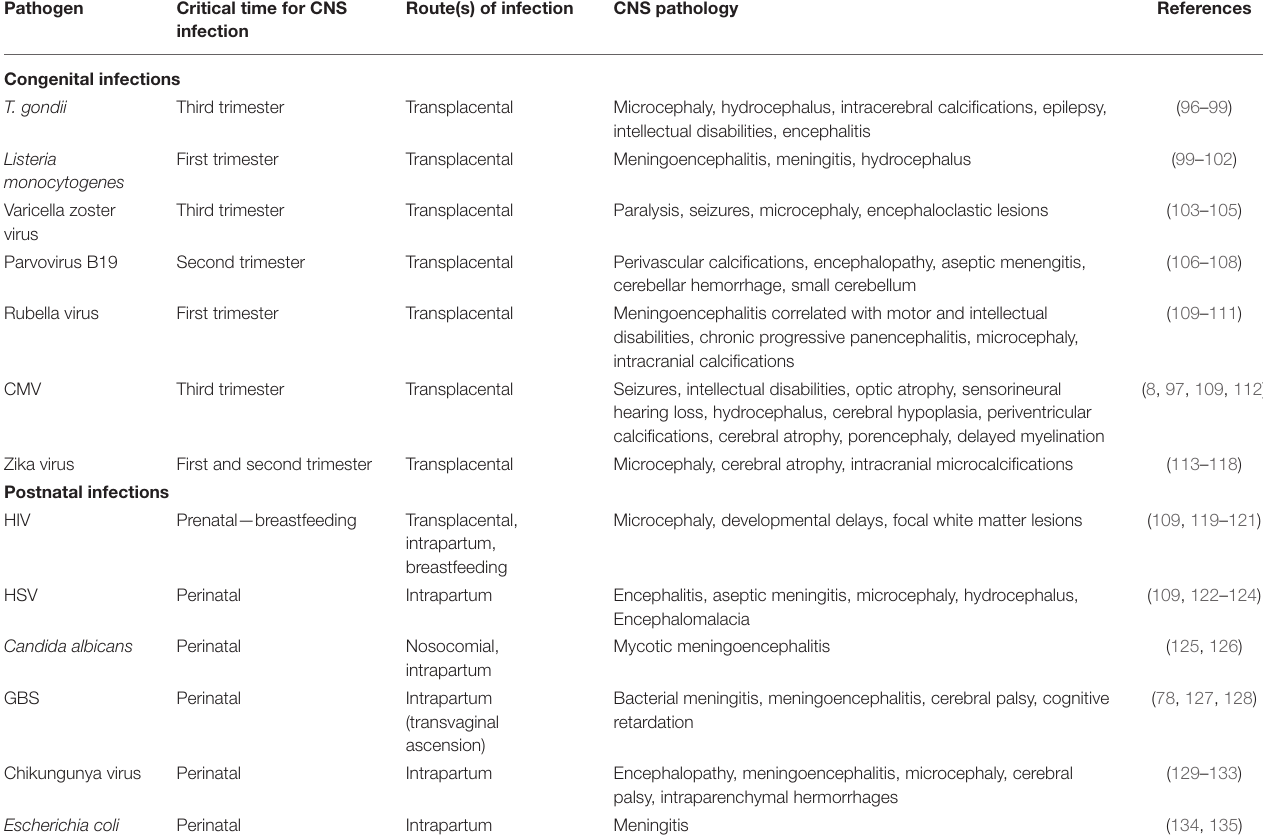
TABLE 1 | Overview of prenatal and postnatal CNS infections.